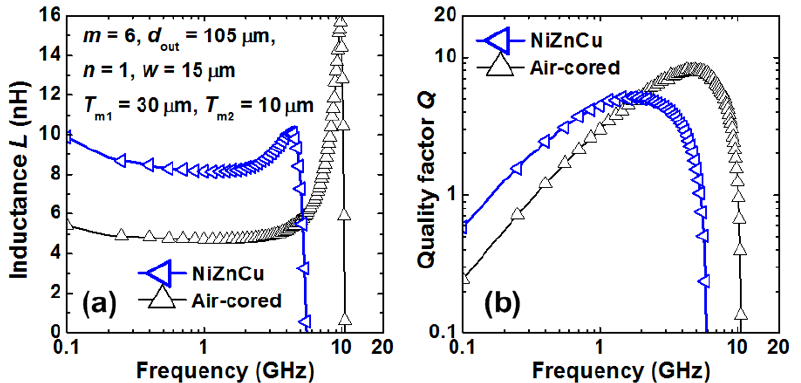
Figure 6. Measured performance improvement of 6-Al-layer (m = 6) single-turn ( n = 1) solenoid-shaped stacked-spiral vnM-L inductors over the air-cored references: ( a ) L, ( b ) Q-factor. (d out : coil out diameter; w: line width) [20].